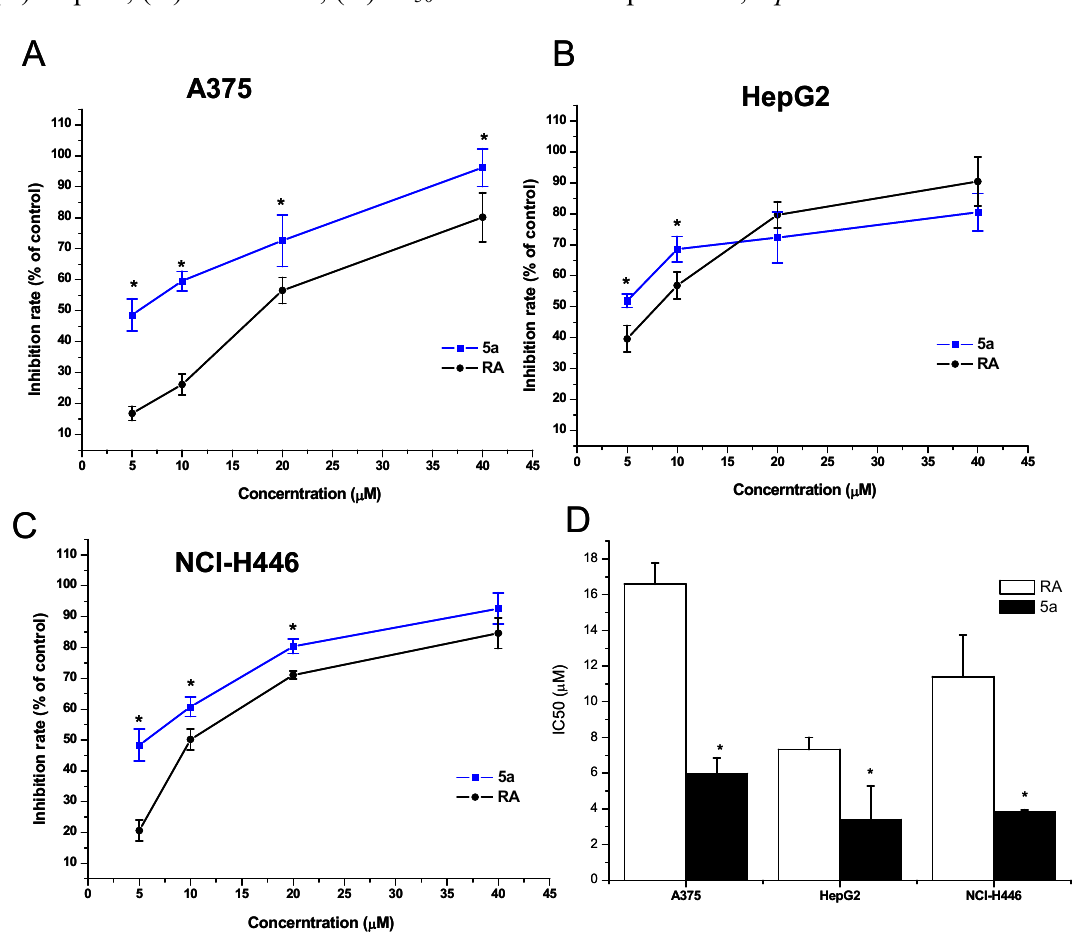
Figure 2. Inhibitory effect of 5a on the human cancer cell proliferation. ( A ) A375; of RA and compound 5a , * p < 0.05 vs. RA ( B ) HepG2; ( C ) NCI-H446; ( D ) IC 50